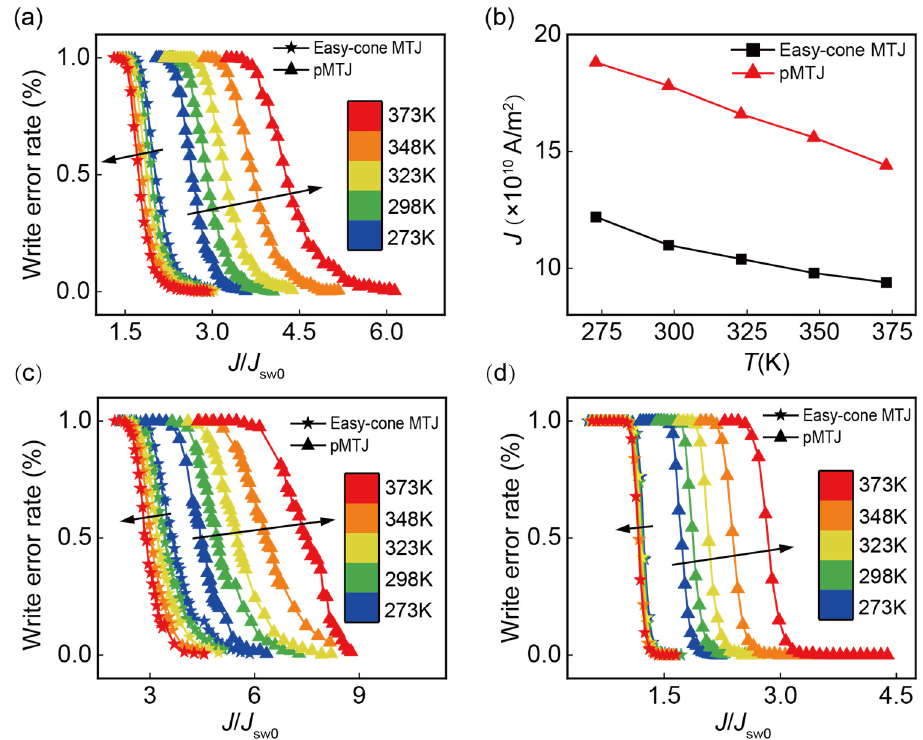
Figure 5. ( a ) Write error rate as a function of current density (normalized by J sw0 ) with pulse duration τ = 2 ns. The easy-cone MTJ and pMTJ are represented by star and triangle, respectively. The arrow indicates the direction of increased temperature. ( b ) The required current density for the write error rate of 10 − 3 at τ = 2 ns. Write error rate as a function of current density (normalized by J sw0 ) with pulse duration τ of ( c ) 1 ns and ( d ) 5 ns.